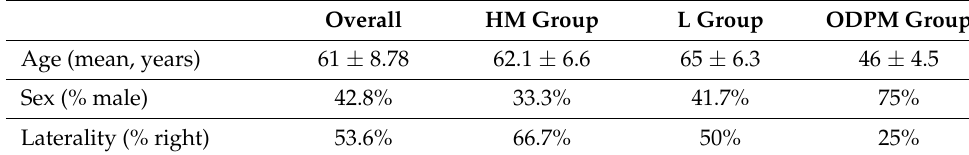
Table 1. The demographic and clinical findings. Overall HM Group L Group ODPM Group Age (mean, years) 61 ± 8.78 62.1 ± 6.6 65 ± 6.3 46 ± 4.5 42.8% 33.3% 41.7% 75% Laterality (% right) 53.6% 66.7% 50%